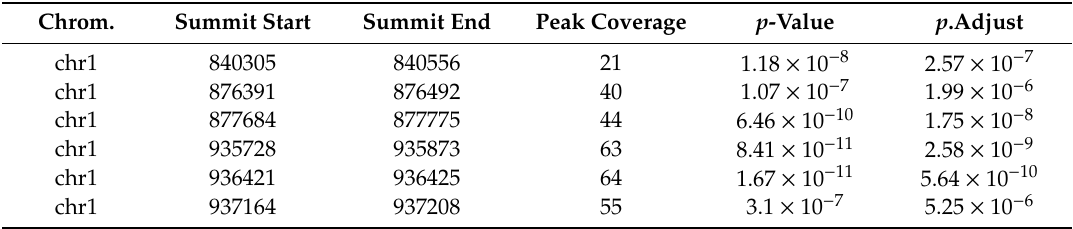
Table A1. Example of peak